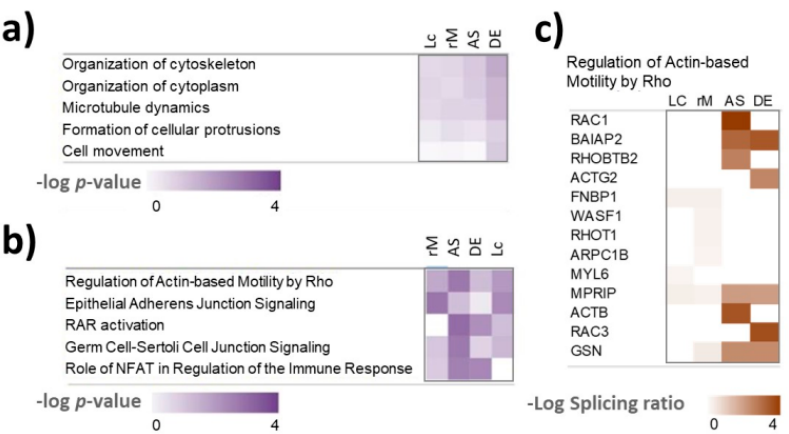
Figure 7. Ingenuity pathway analysis (IPA) of the alternative spliced genes. ( a ) Enrichment of cellular functions. ( b ) Enrichment of canonical pathways. ( c ) Heatmap showing which genes were detected as differentially spliced by the different tools in the actin-based motility by Rho pathway. Lc: LeafCutter; rM: rMATS; AS: ASpli; DE: DEXSeq. Log splicing ratios are absolute values of log Δ PSI for rMATS and LeafCutter and log fold change of exon usage for ASpli and DEXSeq.